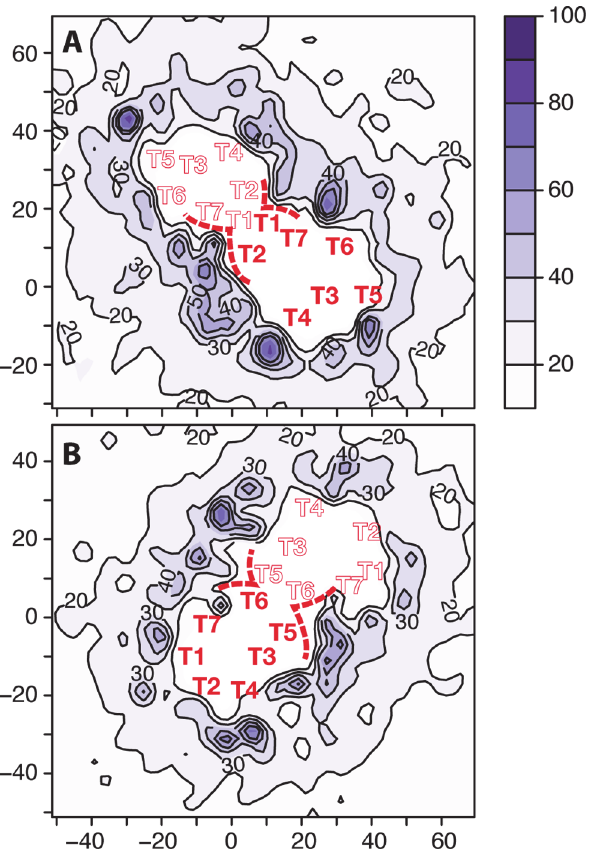
Fig 7. Persistence times of lipid molecules around μ -OR crystallographic interfaces using data from previously published simulations. Panels A and B show the persistence times of lipid molecules that are adjacent to the simulated TM1,2,H8/TM1,2,H8 and TM5,6/TM5,6 crystal dimers, respectively. Approximate locations of the centers of mass of the seven transmembrane helices (TM1-TM7) are indicated with solid and outlined red labels for each protomer, respectively. The lipid-exposed region of the protein surface adjacent to the interface is schematically highlighted with a red dashed line.